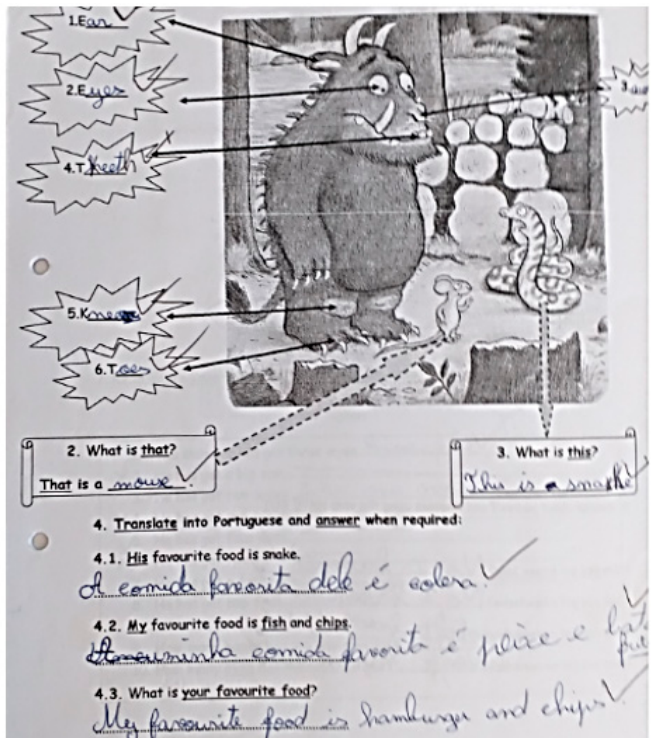
Figure 1. L2 vocabulary acquisition and ability to translate functional sentences.